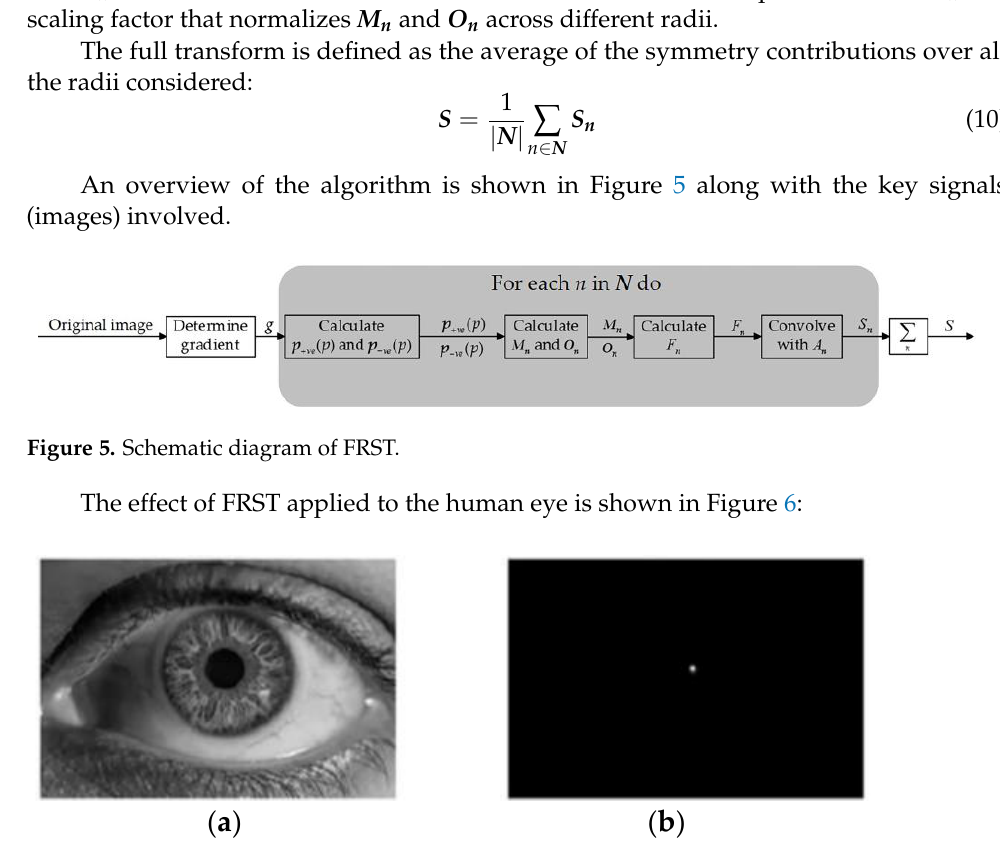
Figure 6. FRST method is applied to the human eye. ( a ) Original image; ( b ) transformed image.